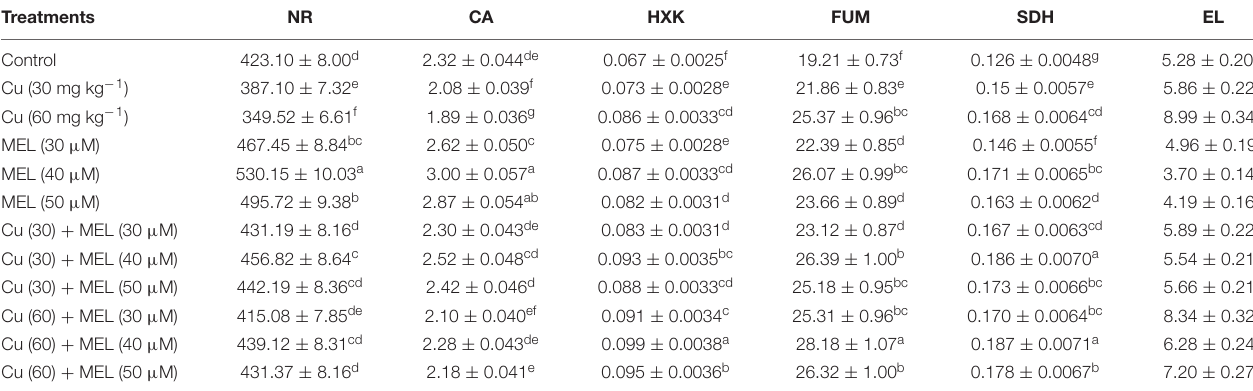
TABLE 5 | Effect of different levels of soil applied Cu (0, 30, or 60 mg kg − 1 ) and MEL (30, 40, or 50 µ M) on, leaf NR [n mole NO 2 g − 1 (FM) s − 1 ], CA [mol (CO 2 ) kg − 1 (leaf FM) s − 1 ], HXK (U mg − 1 protein), FUM ( µ mol mL − 1 fumarate), SDH ( µ g dye reduced g − 1 sample) activities and electrolyte leakage (%) in Brassica juncea at 45 DAS.